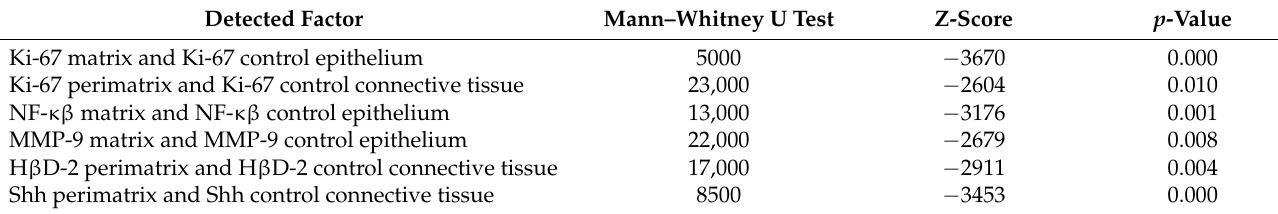
Table 2. Statistically significant differences between patient and control